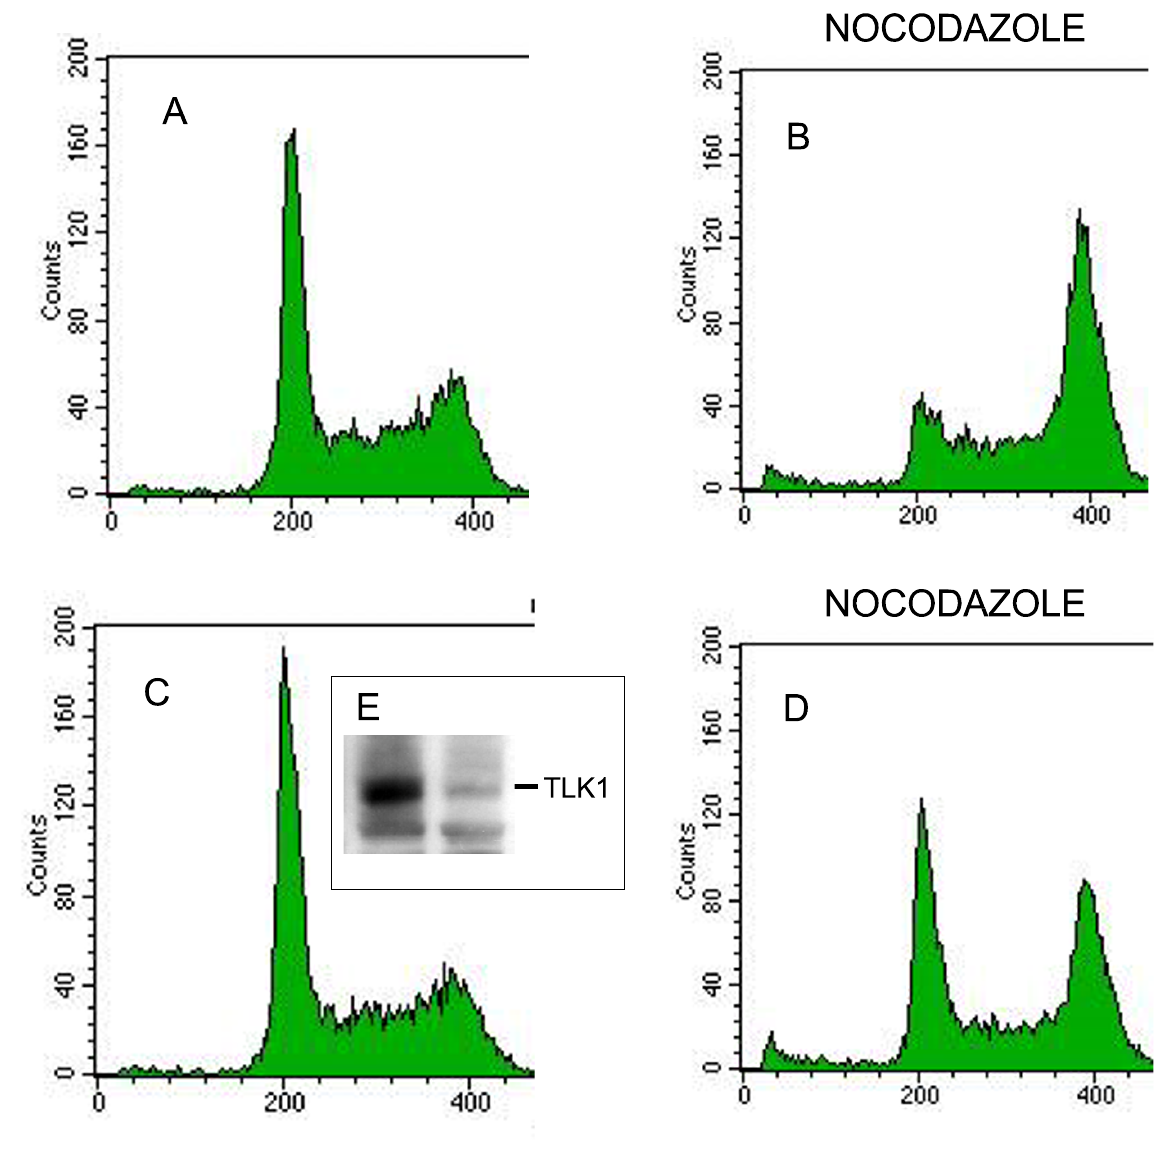
Figure 5 Transfection of siRNA against TLK1 mRNA results in slow progression from G1. Cells were transfected with duplex siRNA oligos, control (scrambled sequence: panel A and B) or TLK1 (panel C and D). Forty-eight hours after transfection, cells were treated (panel B and D), or not, with 1 µ M nocodazole for 18 h. The inserted panel E is a western blot of TLK1 with and with- out treatment with